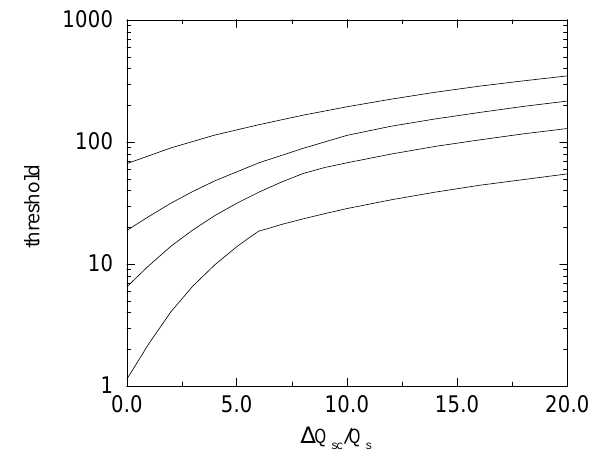
FIG. 14. Threshold value of k (cid:87) (cid:48) t (cid:98) (cid:121) (cid:81) (cid:115) vs D (cid:81) (cid:115)(cid:99) (cid:121) (cid:81) (cid:115) for the analytic square well with x (cid:173) (cid:48) and at (cid:98) (cid:173) (cid:48)(cid:44) (cid:53)(cid:44) (cid:49)(cid:48)(cid:44)(cid:50)(cid:48) , from bottom to top.